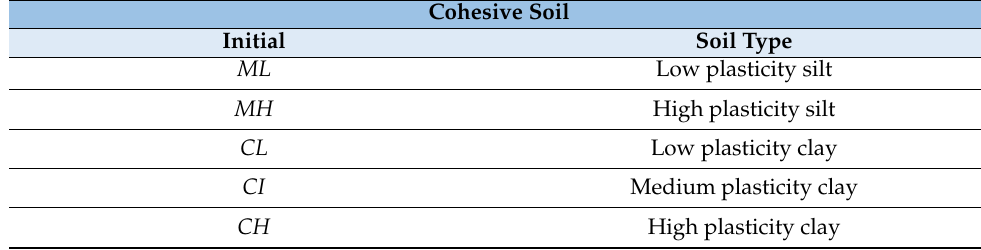
Table 3. Initials for cohesive soils.